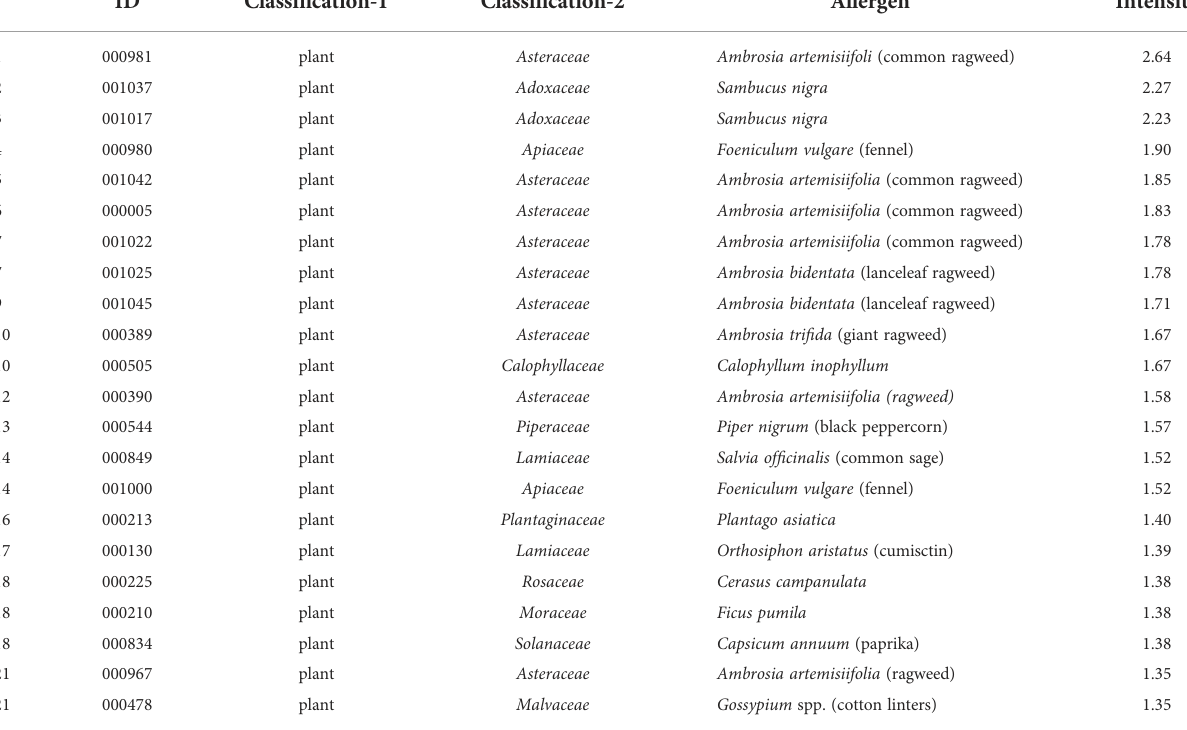
TABLE 1 Relative binding intensity of serum IgE to the respective protein